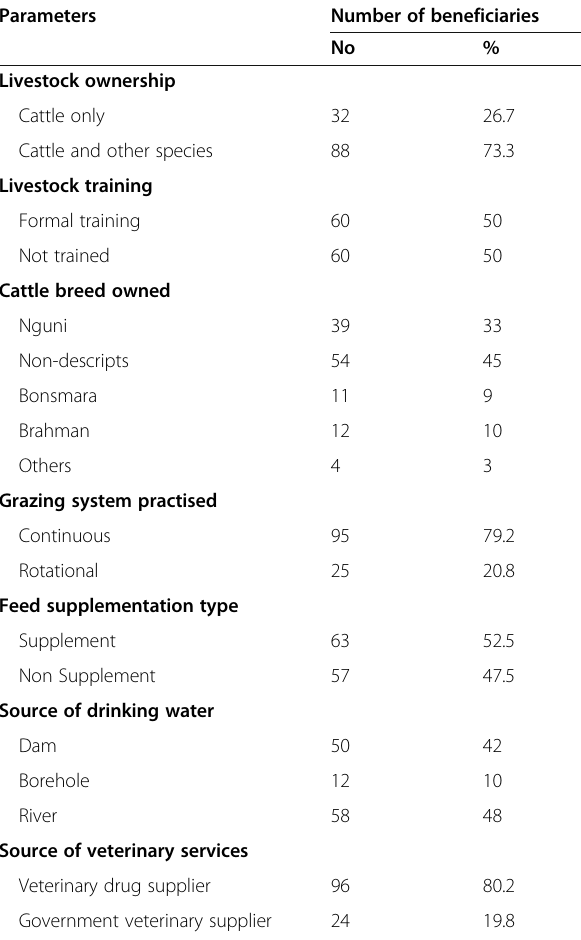
Table 3 Herd dynamics and production system of Nguni cattle farmers (no. =